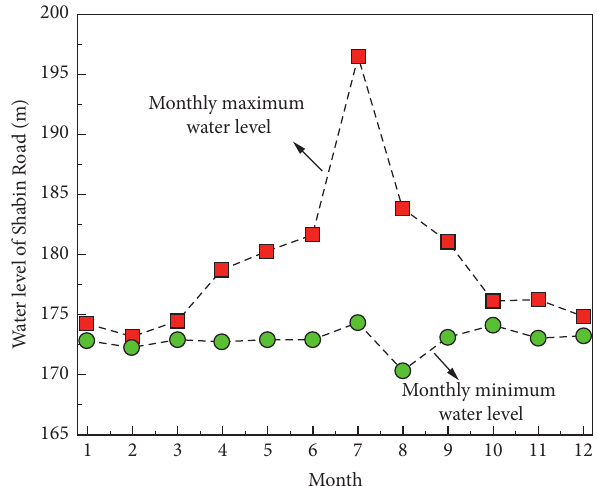
Figure 11: Monthly water level of Shabin Road in 2018.